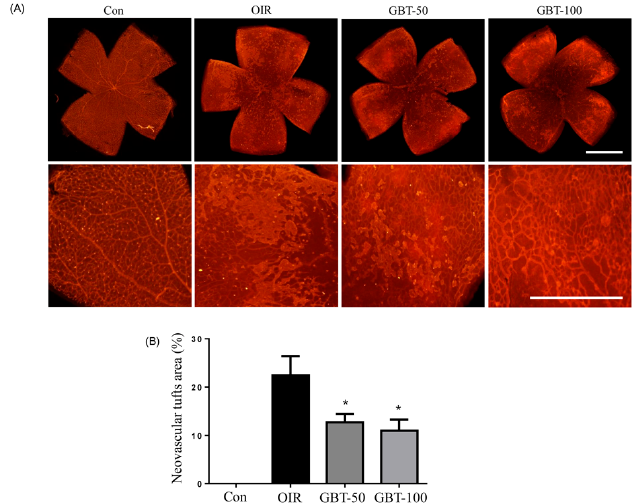
Figure 2. The effect of GBT on retinal neovascular tufts in OIR mice. ( A ) The retinal neovascular tufts were visualized using isolectin B4 staining. Con, normal control mice; OIR, saline-treated OIR mice; GBT-50, OIR mice treated with 50 mg/kg of GBT; and GBT-100, OIR mice treated with 100 mg/kg GBT; Scale bar = 500 µm; ( B ) Quantification results are expressed as neovascular tufts on the retina surface. The bar graph values represent the mean ± SE ( n = 5). * p < 0.05 for OIR group vs. GBT-treated group.